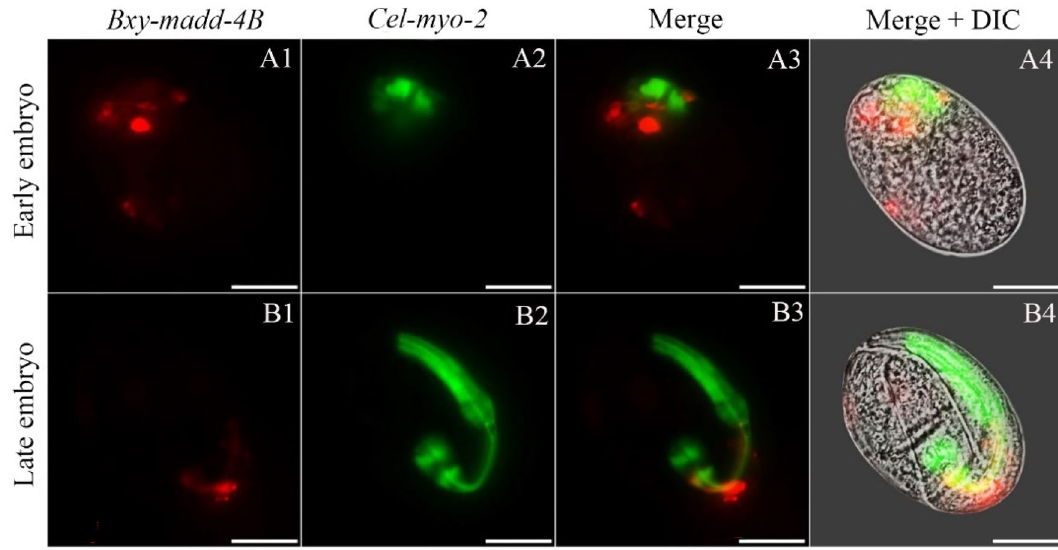
Figure 6. Localization of Bxy-madd-4B on translational level via transgenic C. elegan s during embryonic development. The expression patterns of mCherry (red) under control of B. xylophylus madd-4B promoter and green fluorescent protein gene (green) was driven by C. elegans promoter myo-2 as a marker for pharynx development. Fluorescent (A1–A3 and B1–B3) and differential interference contrast (DIC) merged (A4 and B4) microscope images of the second filial generation transgenic C. elegans embryos carrying both Bxy-madd- 4Bp ::mCherry and Pmyo-2 ::GFP transgenes. Early embryo was raised at 20 °C for 6 h and late embryo was raised at 20 °C for 12 h. In all cases, images are representative of 50 embryos. The scale bar stands for 10